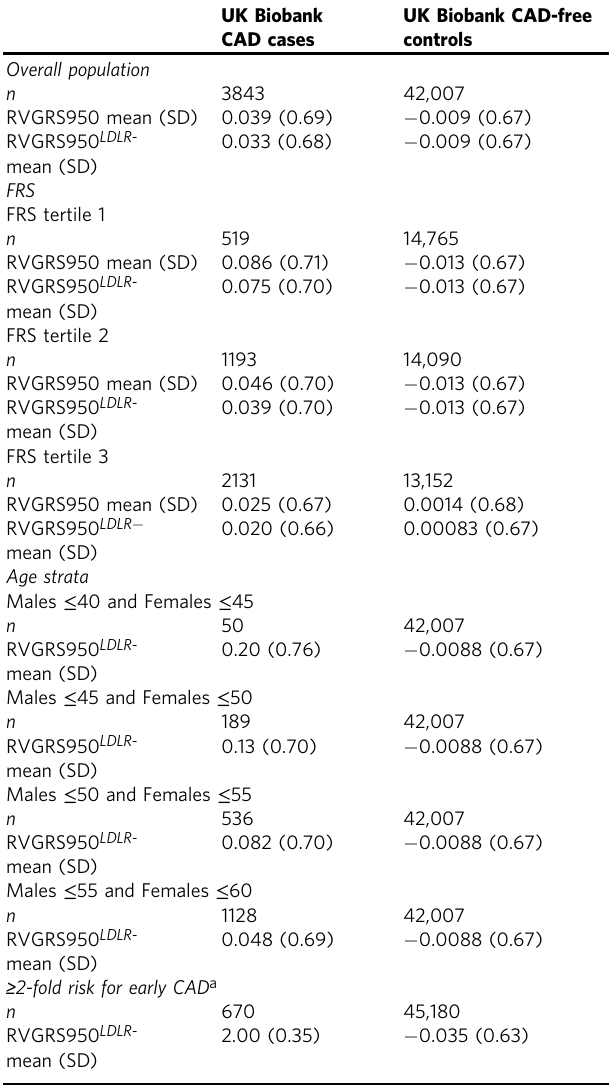
Table 1 Summary of the RVGRS950 and RVGRS950 LDLR − distributions in the UK Biobank validation